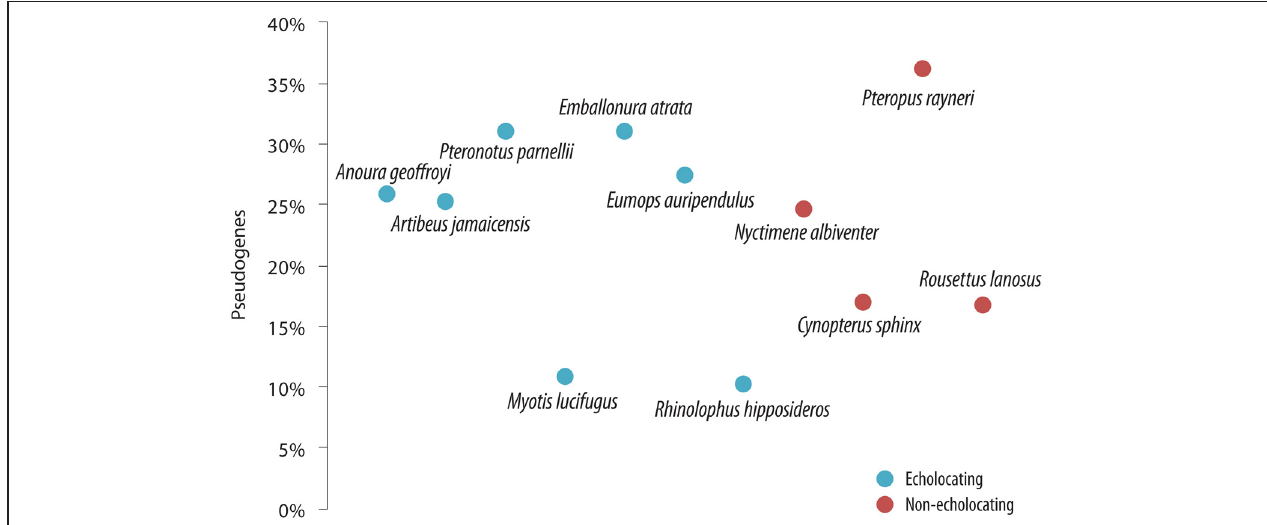
FIGURE 5 | The proportion of olfactory receptor ( OR ) genes that have become pseudogenes in a range of bat species that use laryngeal echolocation (blue symbols) compared with species that do not (red symbols). From Hayden et al. (2010), reproduced with permission from Cold Spring Harbor Laboratory Press.